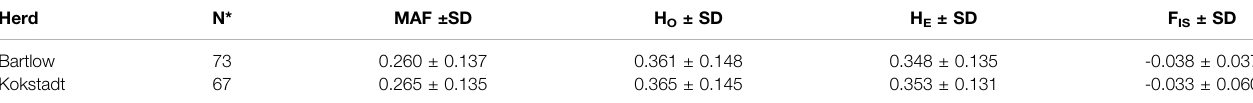
TABLE 2 | Minor allele frequency (MAF), observed (H O ) and expected (H E ) heterozygosities and, inbreeding coef fi cient (F IS) of Nguni cattle from Bartlow and Kokstadt herds. Herd